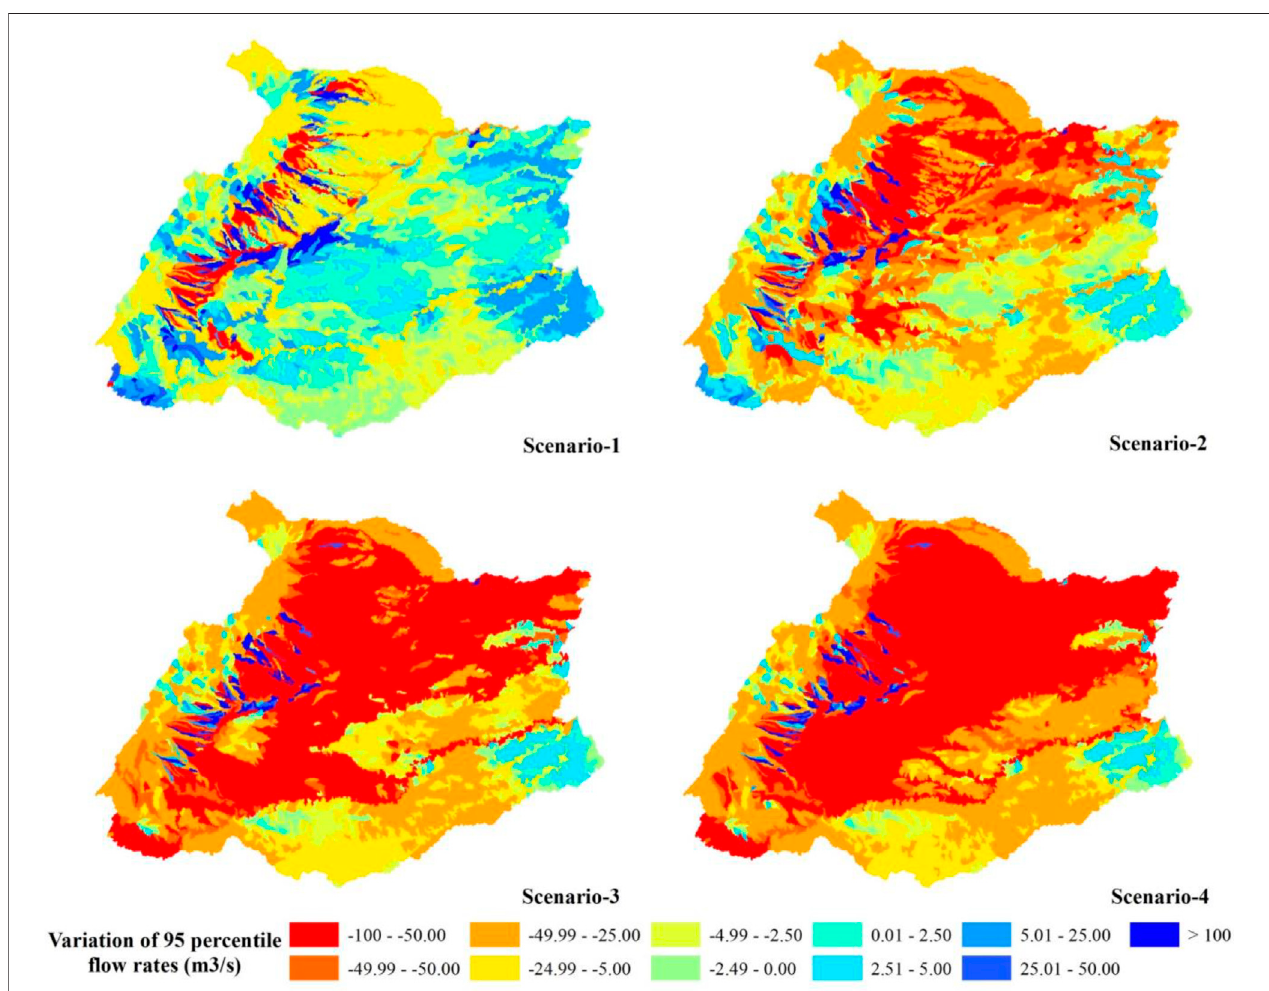
FIGURE 9 | Spatial distribution of the normalized percentage variations of the fl ows associated with the 95th percentile (Q95) of the fl ow duration curve for the analysis scenarios.